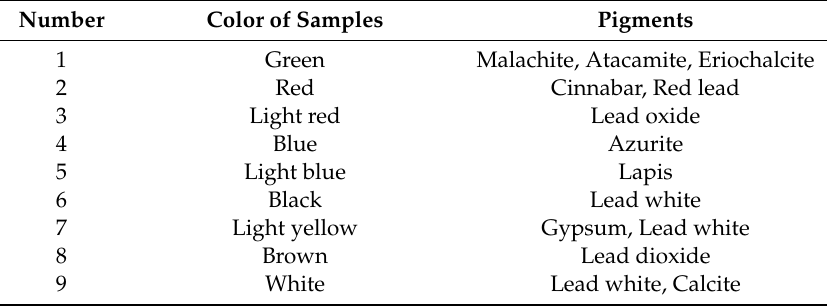
Table 13. Inorganic mineral pigment analysis